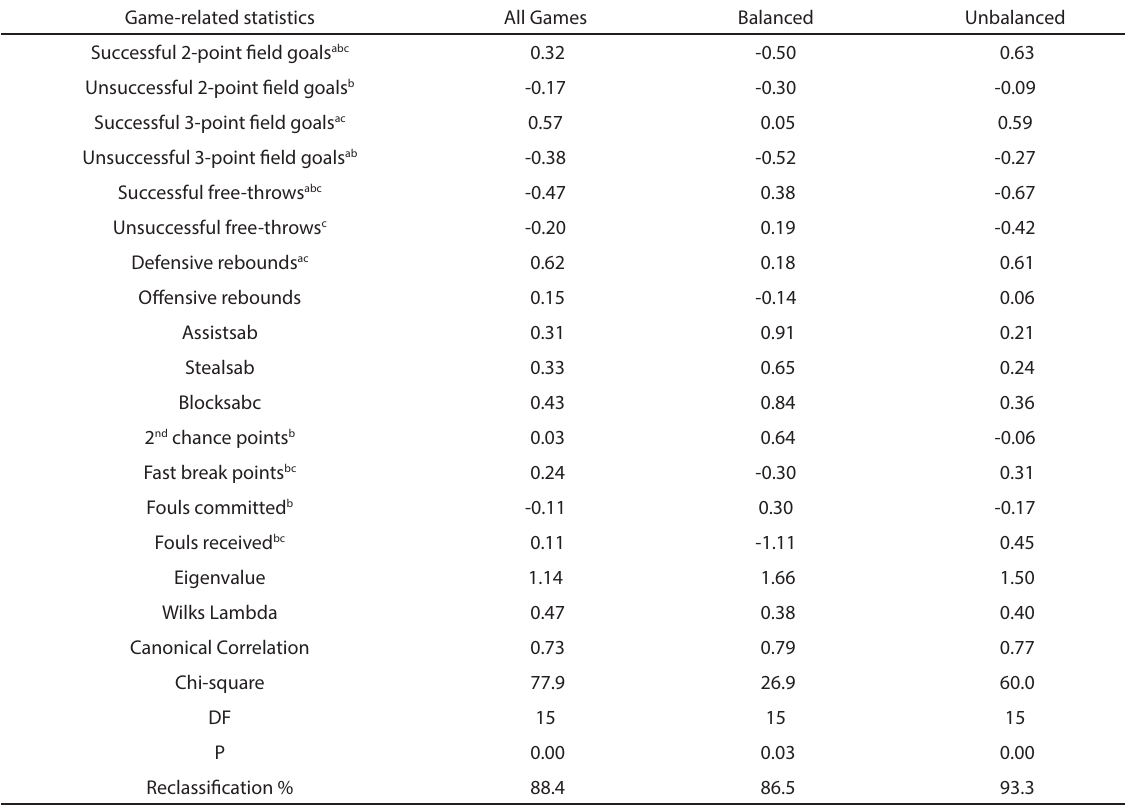
Table 2. Discriminant analysis structure coefficients for game-related statistics of winning and losing